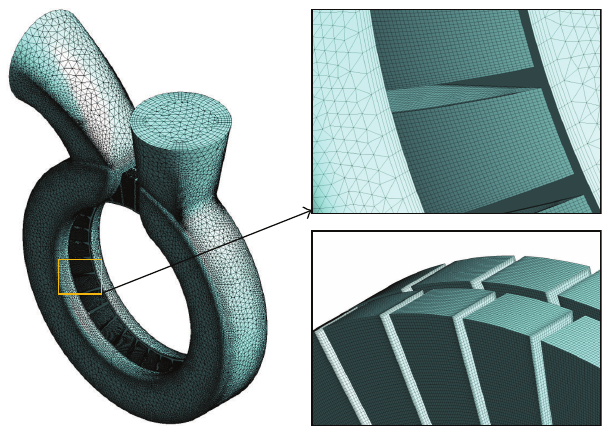
Figure 5: CFD grids of geometries.